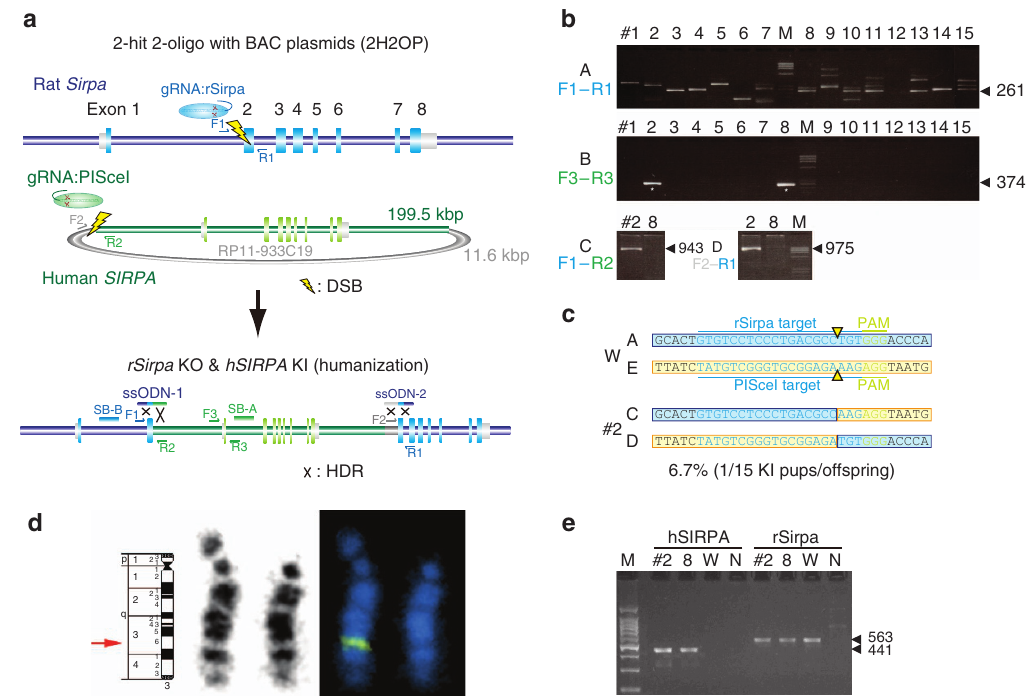
Figure 4 | Human BAC KI at the SIRPA locus. ( a ) Schematic representation of the BAC KI by 2H2OP. The rat Sirpa gene was knocked out by KI of the 200- kb BAC (RP11-933C19), which contains the human SIRPA locus. ( b ) PCR analysis of pups with primer sets F1–3 and R1–3, as indicated in a . Many pups showed indel mutations at the targeted rat Sirpa locus compared with the 261-bp wild-type allele (arrow) (A) and two pups showed a human SIRPA -positive PCR band (asterisk) (B). Rat number 2 was positive for ligation between both sides of rat Sirpa and human SIRPA (C,D). Arrows indicated the predicted PCR fragment sizes. ( c ) Sequence analysis of pups indicated that rat number 2 carried accurate conjunction at both cut ends. ( d ) The heterozygous SIRPA -KI allele was confirmed by FISH on rat chromosome 3q35 (arrow). ( e ) Reverse transcriptase–PCR analysis of human SIRPA mRNA in the liver of rat numbers 2 and 8. N, negative control; W, control